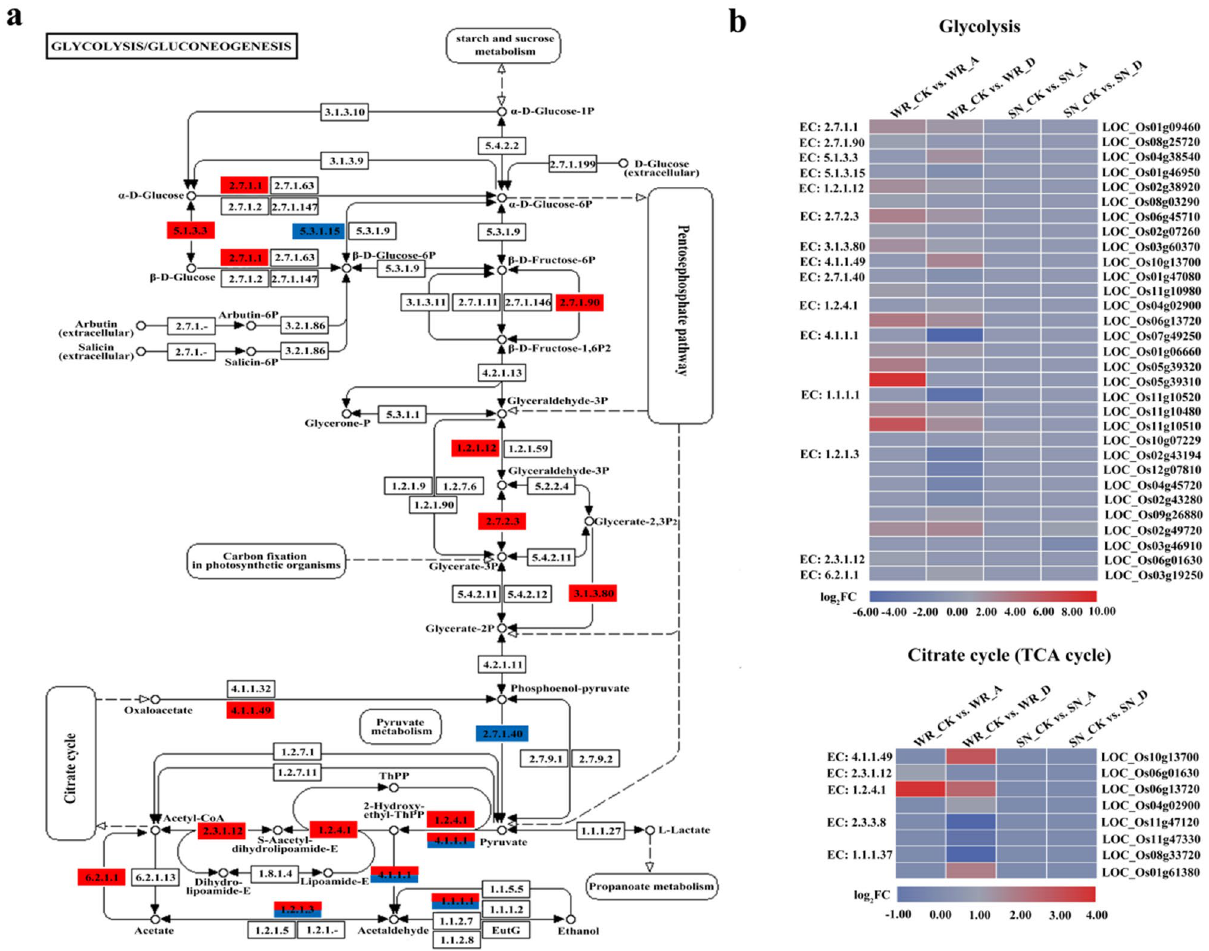
Figure 7. DEGs relevant to glycolytic metabolism and the citrate cycle after treatment with ABA or diniconazole. ( a ) Change in transcript expression levels associated with glycolysis and citrate cycle pathways in WR04-6 and SN9816 plants after ABA and diniconazole treatment. ( b ) Expression patterns of genes involved in glycolysis and citrate cycle pathways in the four pairwise transcriptome